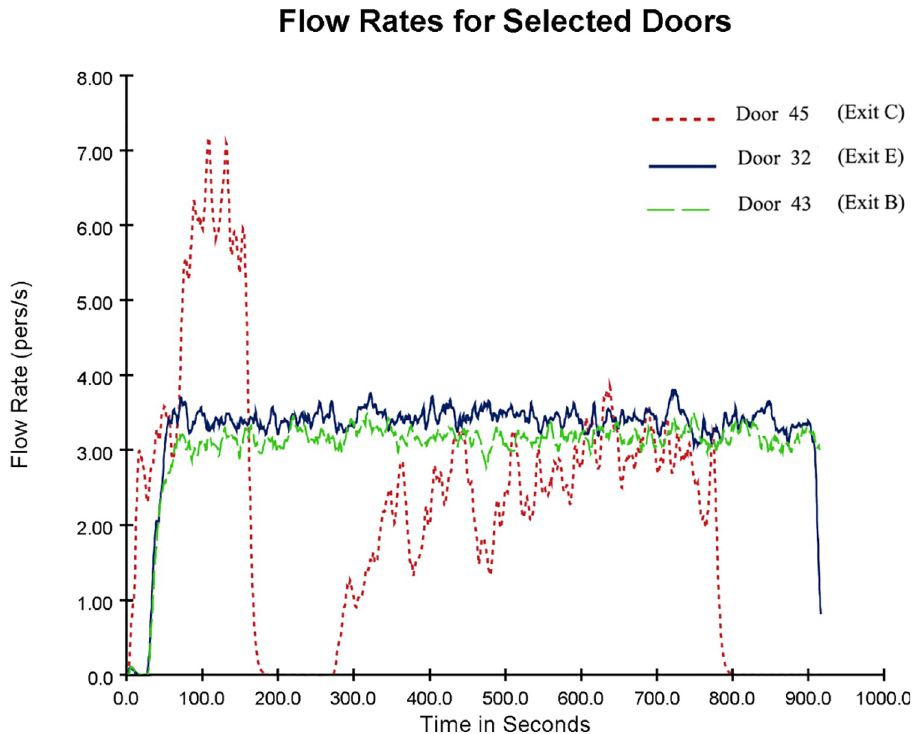
Fig 9. Flow variation diagram for Exits B, C and E (optimized evacuation simulation